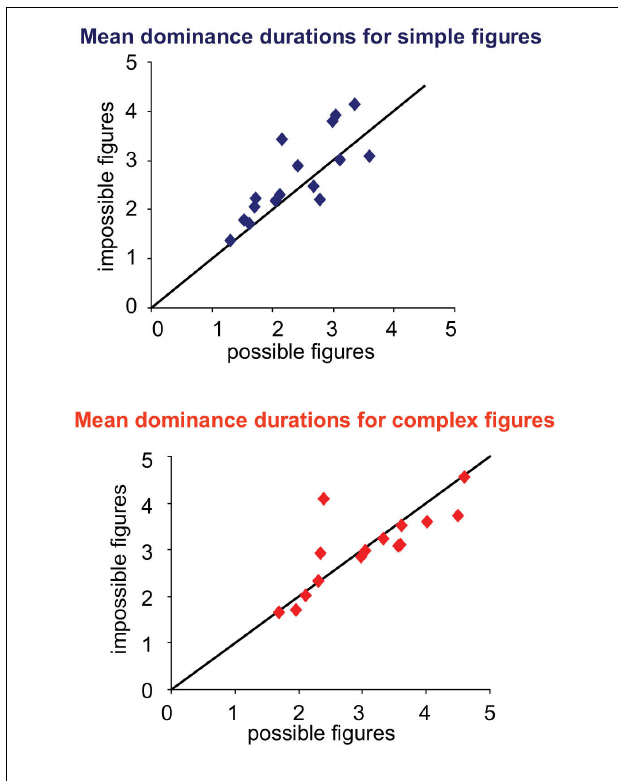
FIGURE 6 | Mean dominance duration scatter plots by subject for simple (top) and complex (bottom) figures. For simple figures, most points are above the equality line indicating longer dominance durations for impossible figures. For complex figures, points are mostly close to the equality